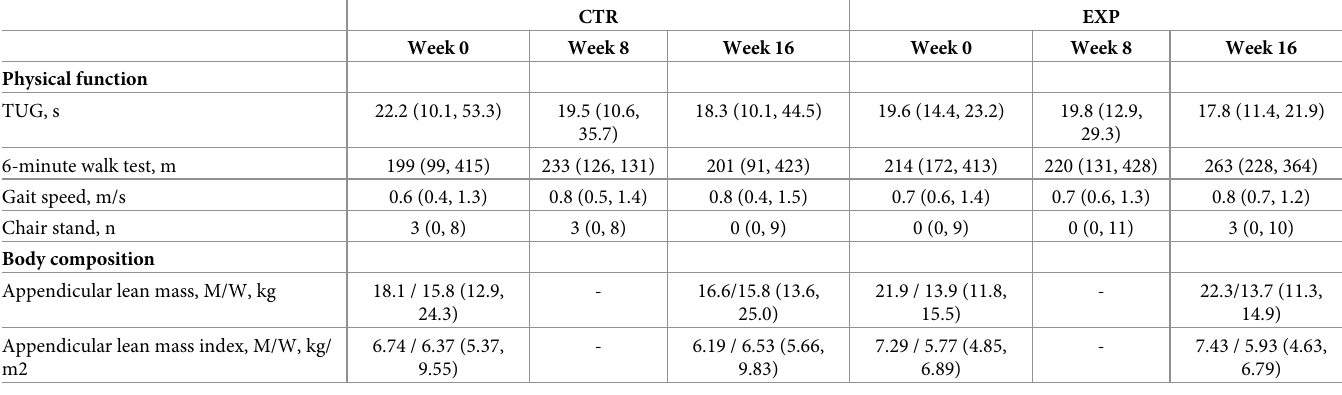
Table 3. Physical function and body composition of participants by